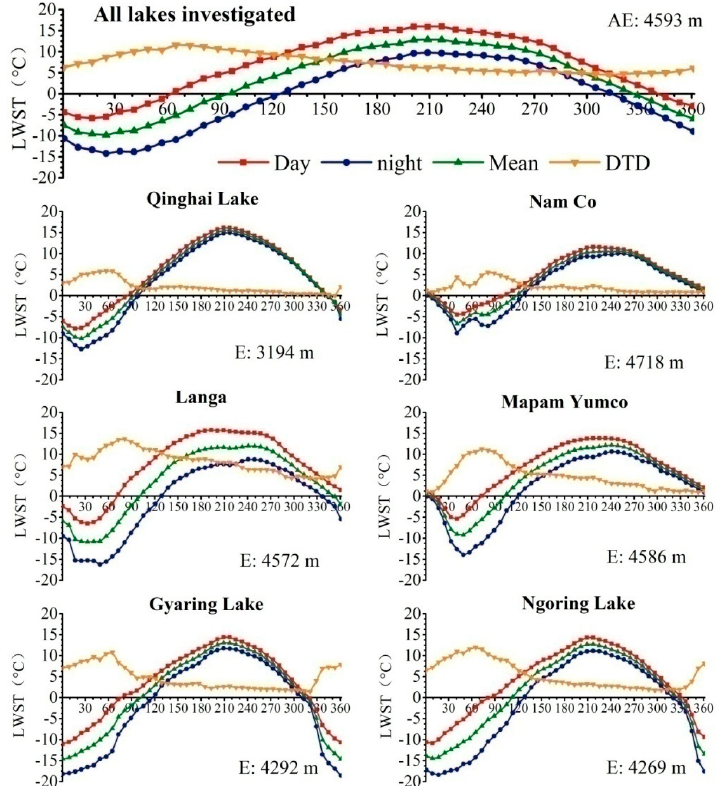
Figure 7 . Fifteen-year averaged water surface temperature for daytime, nighttime and the mean value of day-nighttime temperature, and the diurnal temperature differences (DTD), the first row is derived from 56 lakes across the plateau, and the second to the fourth rows are results from typical lakes. E denotes the average elevation of 56 lakes above sea level in meter (m).